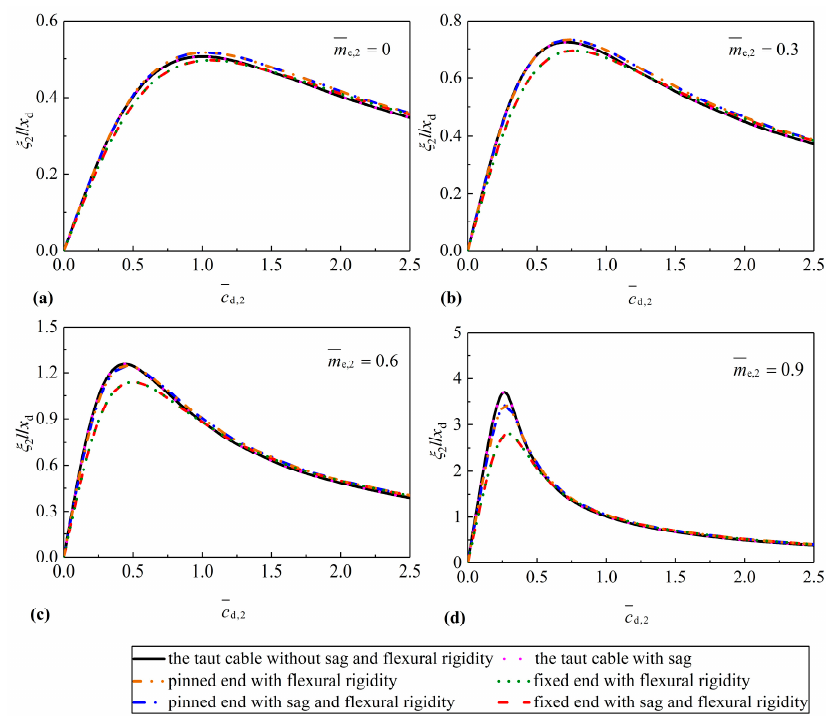
Figure 12. The first supplemental modal damping ratio of the long cable versus damping coefficient 285 for various inertial masses: ( a )